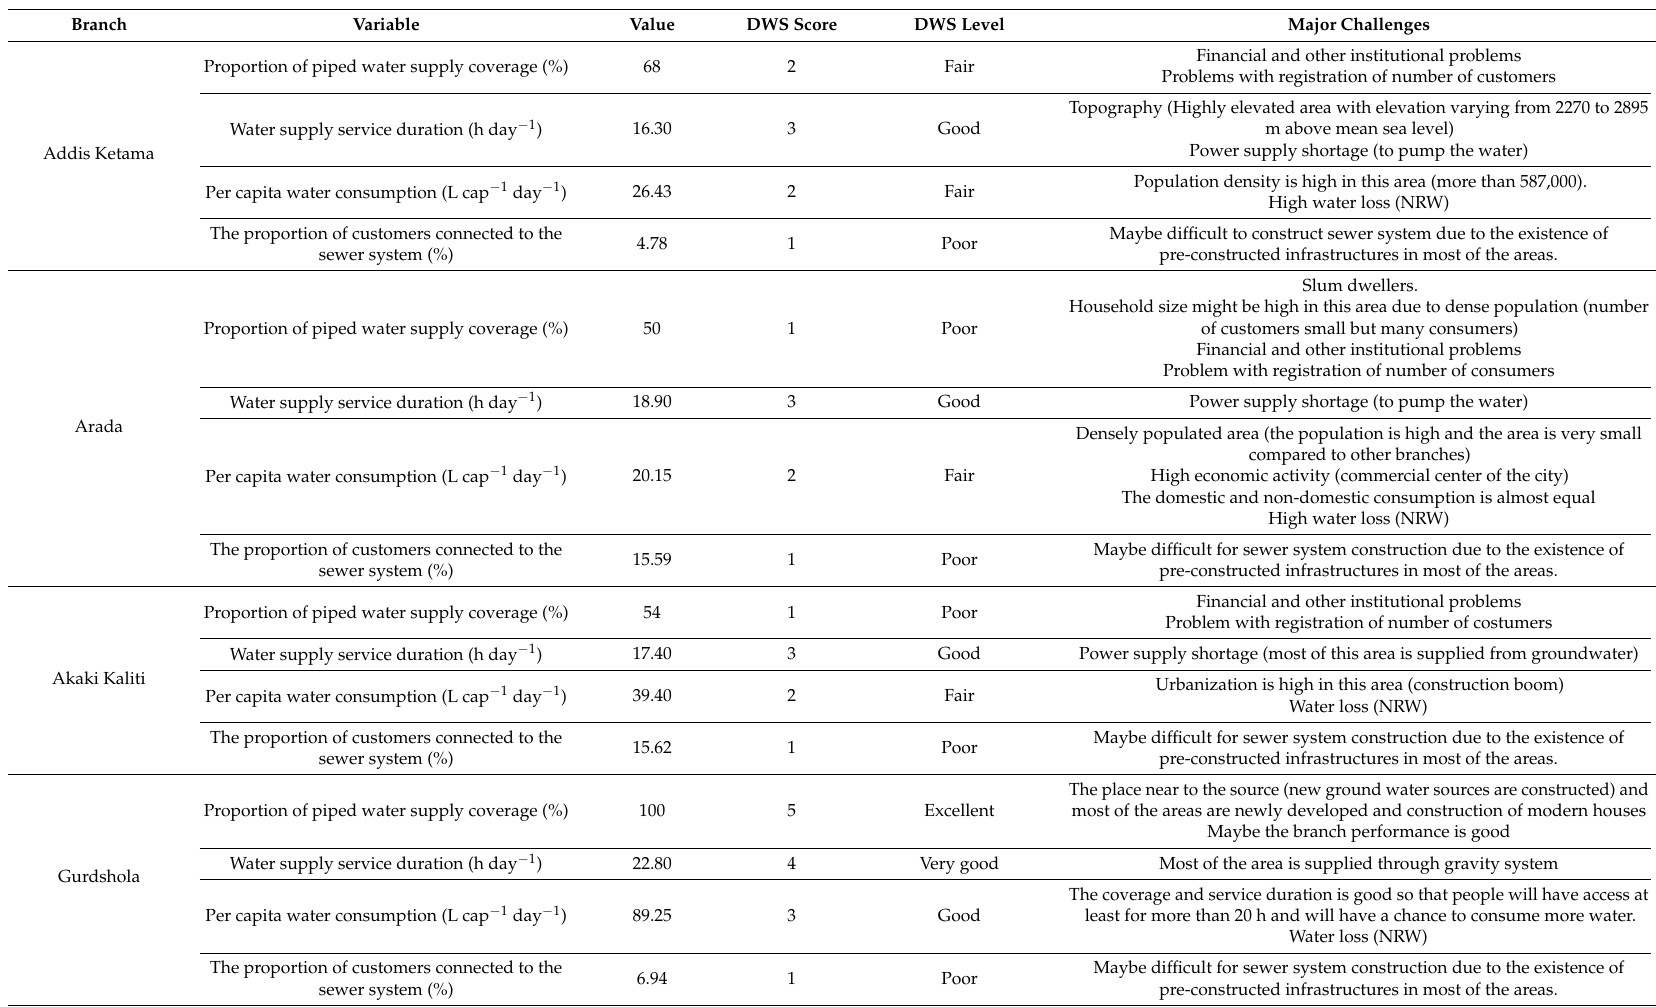
Table 4. Discussion on possible reasons for the domestic water security (DWS) values at each branch for